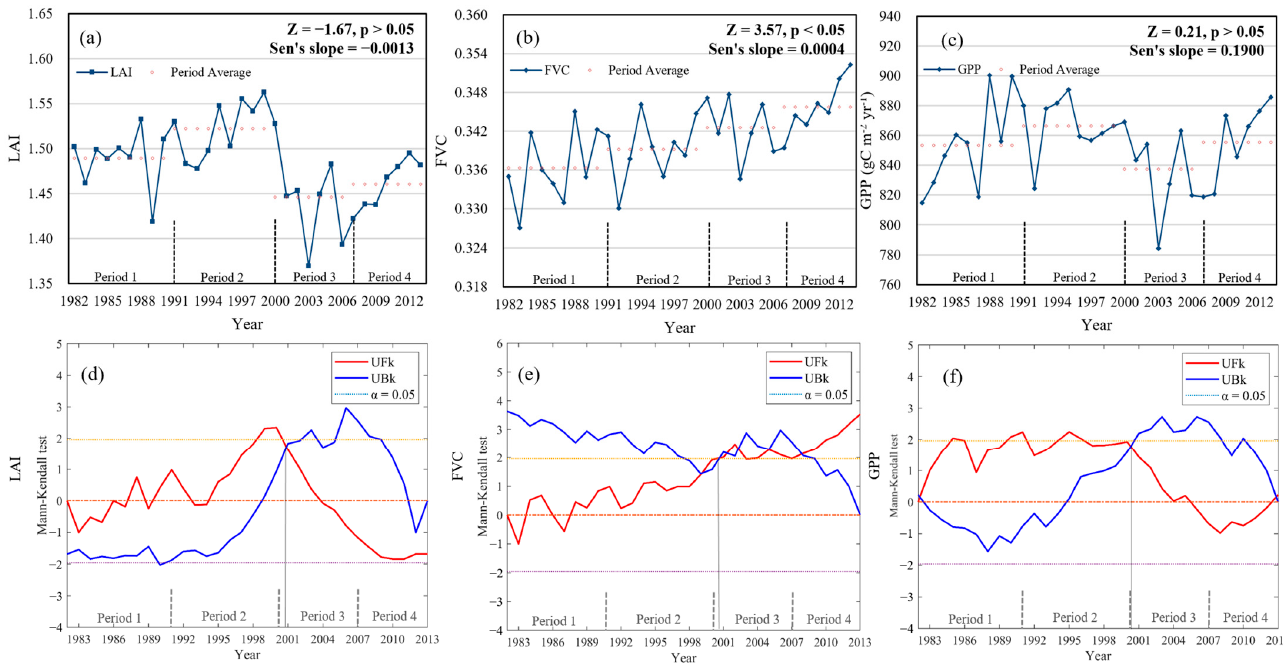
Figure 3. Temporal changes in area-averaged annual LAI ( a ), FVC ( b ) and GPP ( c ), and sequential Mann–Kendall tests for the annual LAI ( d ), FVC ( e ) and GPP ( f ) with the forward-trend UFk and backward-trend UBk in the ARB during 1982–2013. p < 0.05 indicates significance at the 95% confident level.